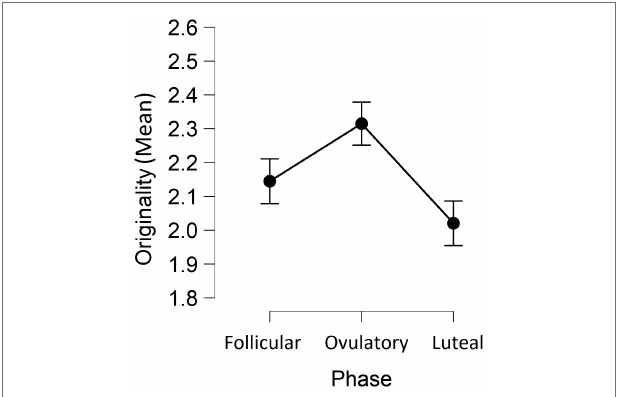
FIGURE 1 | Mean scores of originality of ideas in each phase of the ovulatory